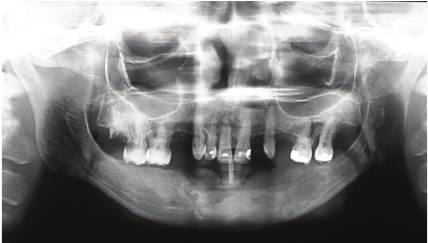
Figure 9: Panoramic radiograph 12 months after the